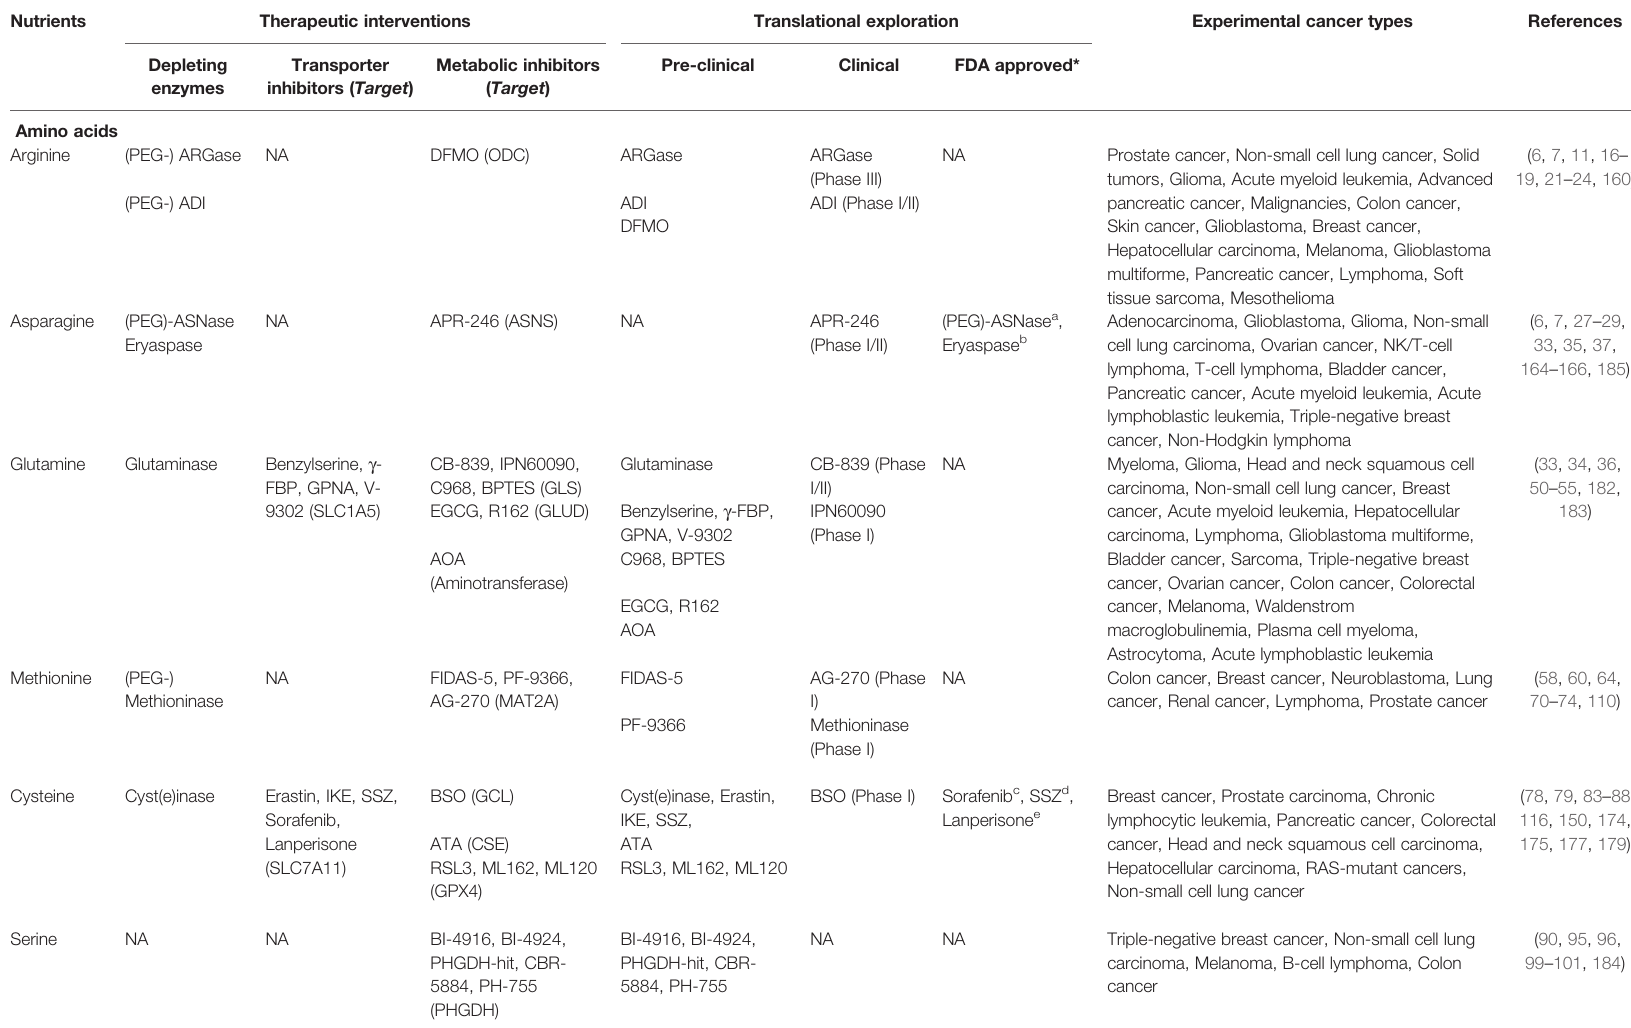
TABLE 1 | Therapeutic exploitation of targeting nutrient dependency in cancer